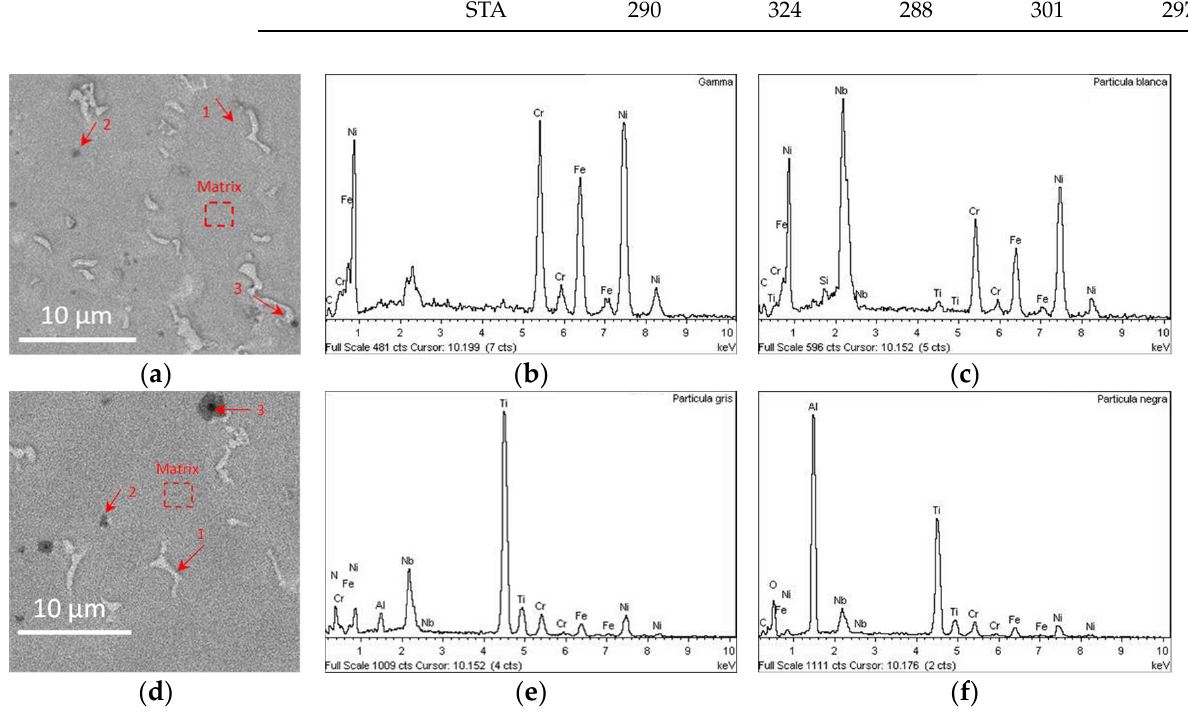
Figure 10. SEM analysis: ( a ) as-deposited sample; ( d ) direct-aged sample; ( b ) matrix EDS; ( c ) 1-white particle EDS (Laves phase); ( e ) 2-Grey particle EDS; ( f ) 3-Black particle EDS.